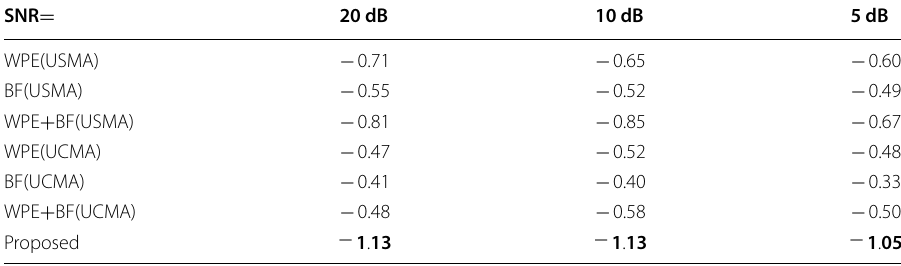
Boldface indicates the best score for each condition